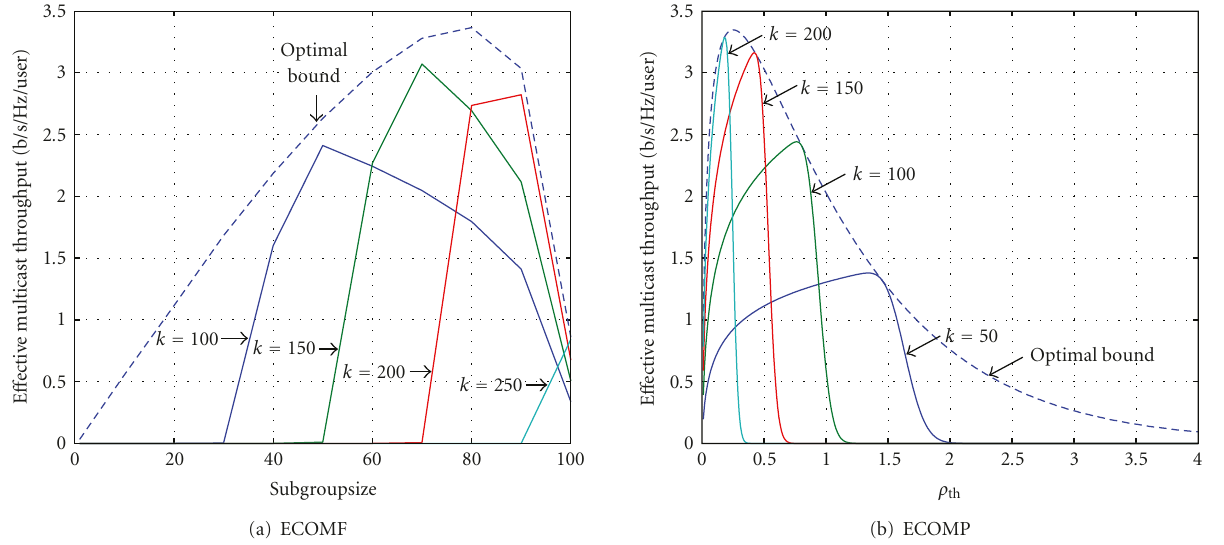
Figure 2: E ff ective multicast throughput versus ρ ∗ for ECOM schemes using RS(256, k ) in a Rayleigh fading channel with an average SNR of 20dB.